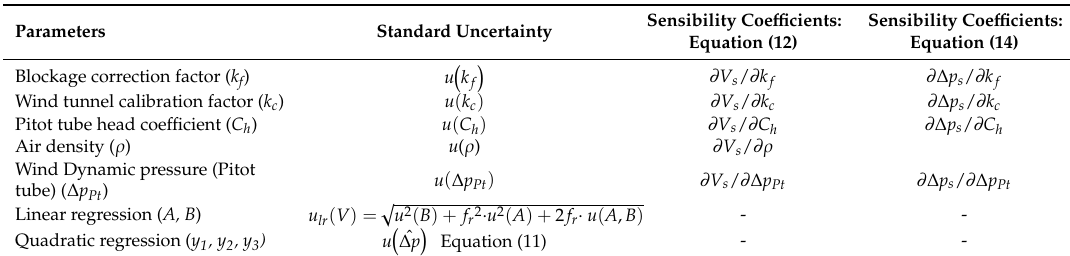
Table 1. Standard uncertainty and sensibility coe ffi cients for each parameter included in the calibration